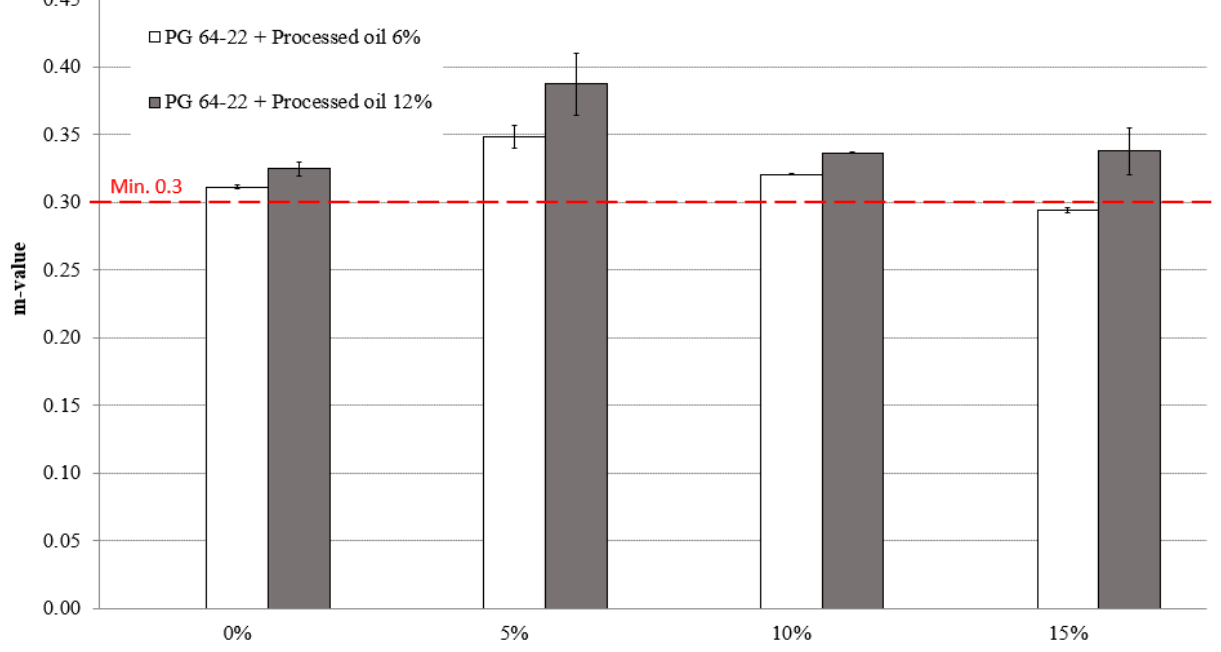
Figure 9. m ‐ value of RTFO + PAV aged PG 64 ‐ 22 binders with processed oil as a function of SBS Figure 9. m-value of RTFO + PAV aged PG 64-22 binders with processed oil as a function of SBS content at − 12 °C. content at − 12 ◦